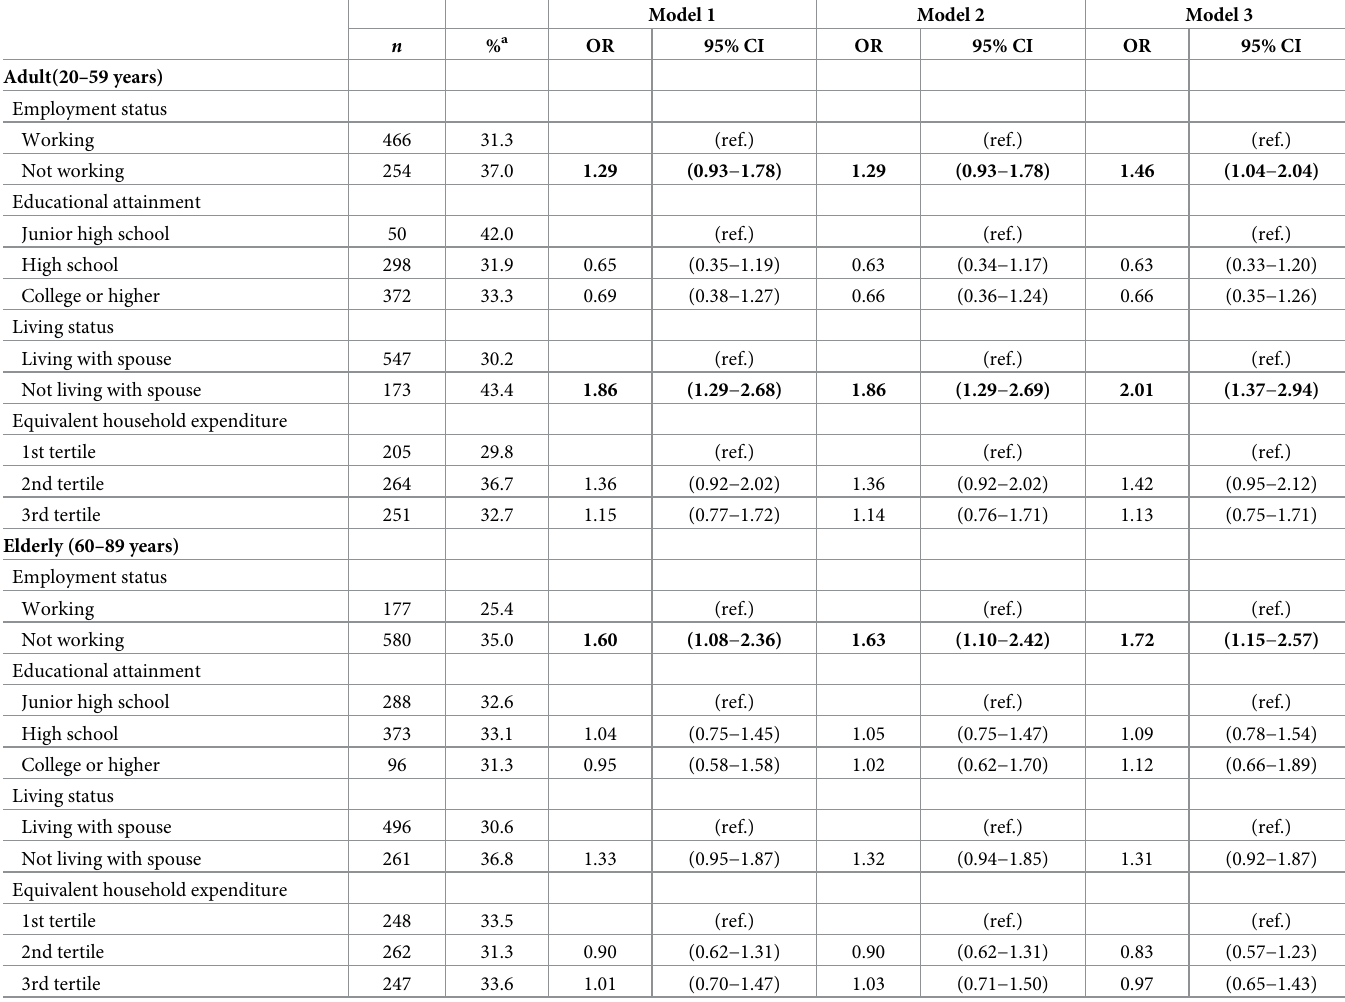
Table 4. Association between socioeconomic status and physical inactivity in women ( n =